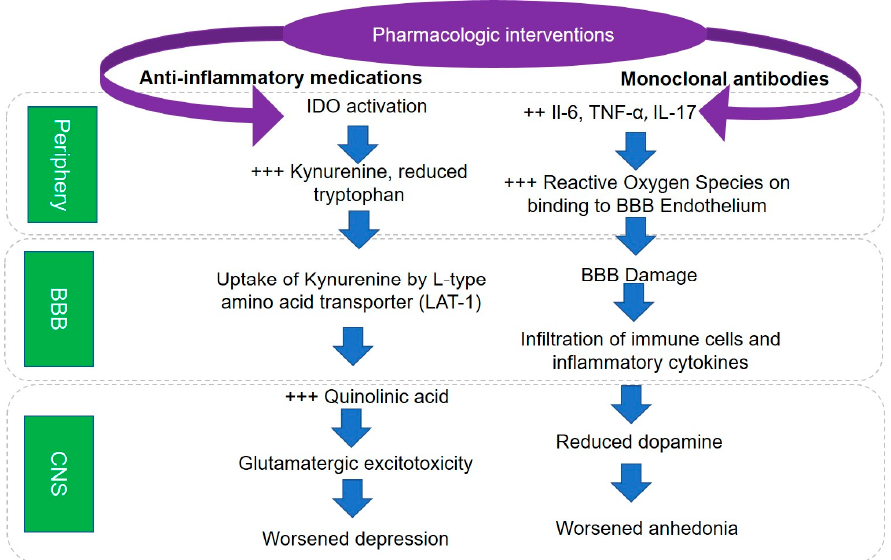
Figure 2. Theoretical framework for developing novel antidepressants by targeting inflammatory pathways. Two distinct pharmacologic interventions with the potential to reduce depressive symptom severity. In the first pathway, activation of indoleamine oxygenase (IDO) results in increased levels of kynurenine, which is taken up by LAT-1 transporters and converted to Quinolinic acid by microglial cells. This results in glutamatergic excitotoxicity and depressive symptoms. Blockade of the LAT-1 transporter by a pharmacologic agent can disrupt this cascade and reduce depressive symptoms and mitigate central nervous system (CNS) effects of peripheral inflammation. Similarly, anti-cytokine treatments may be effective in depressed patients with elevated levels of inflammatory cytokines (interleukin 6 or IL-6, interleukin 17 or IL-17, and tumor necrosis factor alpha or TNF- α ), which result in blood-brain barrier (BBB) dysfunction.